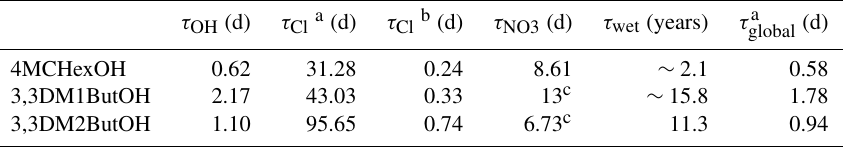
Table 7. Lifetimes of 4MCHexOH, 3,3DM1ButOH, and 3,3DM2ButOH.